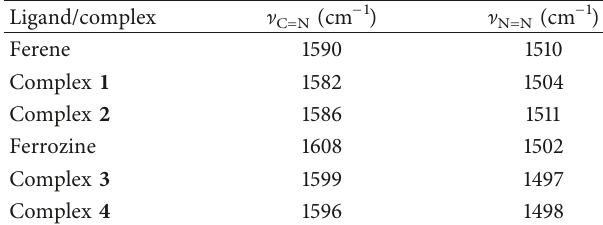
Table 3: FTIR data of complexes 1–4